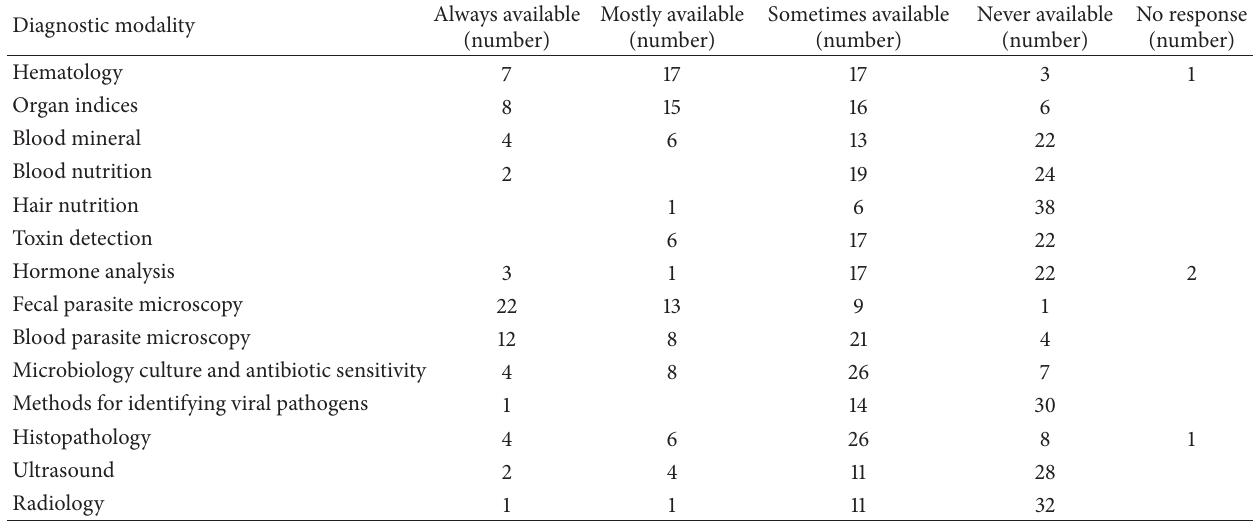
Table 4: Availability of laboratory facilities reported by survey respondents ( 𝑛 = 45 ).